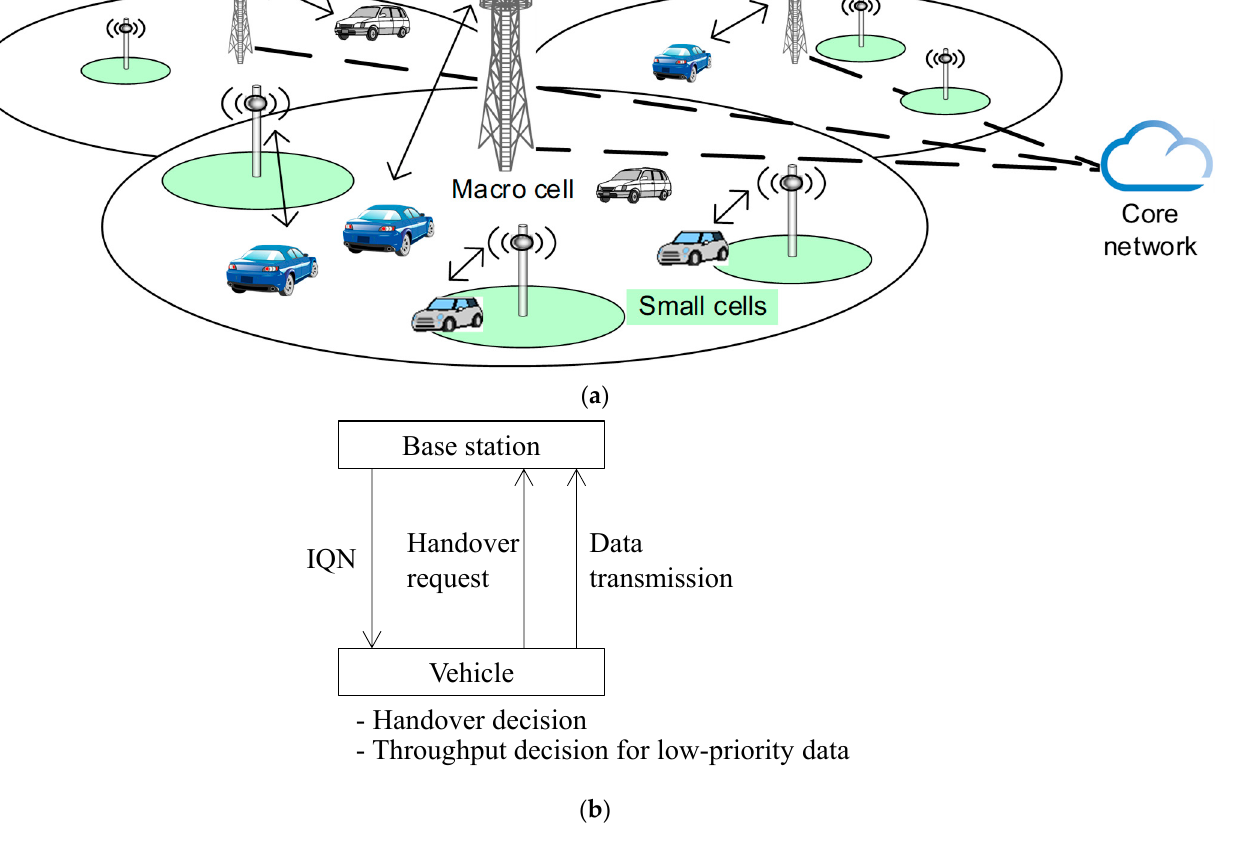
Figure 1. Outline of proposed system; ( a ) system model, ( b ) overview of proposed algorithm.